Question: Describe this figure in one sentence.
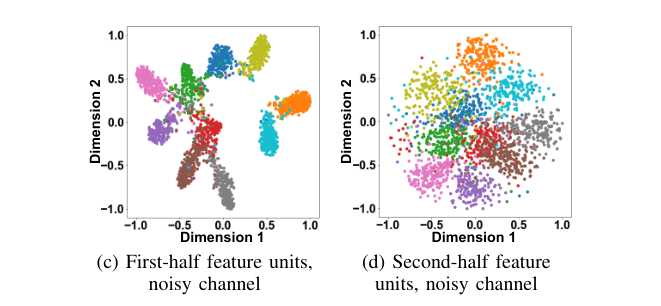
Answer: Comparison of feature-level channel resilience between the ideal (noise = 0) and noisy (SNR = 0) channel conditions.